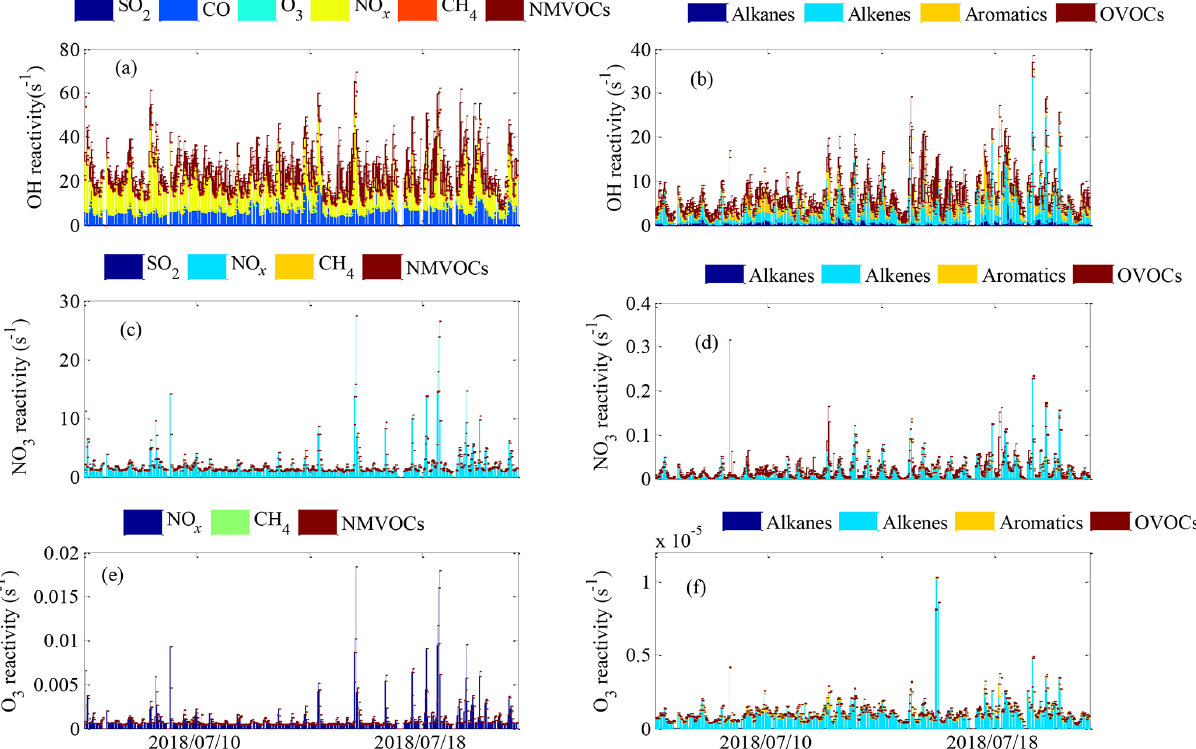
Figure 4. The time series of (a, b) OH reactivity, (c, d) NO 3 reactivity and (e, f) O 3 reactivity during the field campaign at Xianghe from 6 July to 6 August 2018.